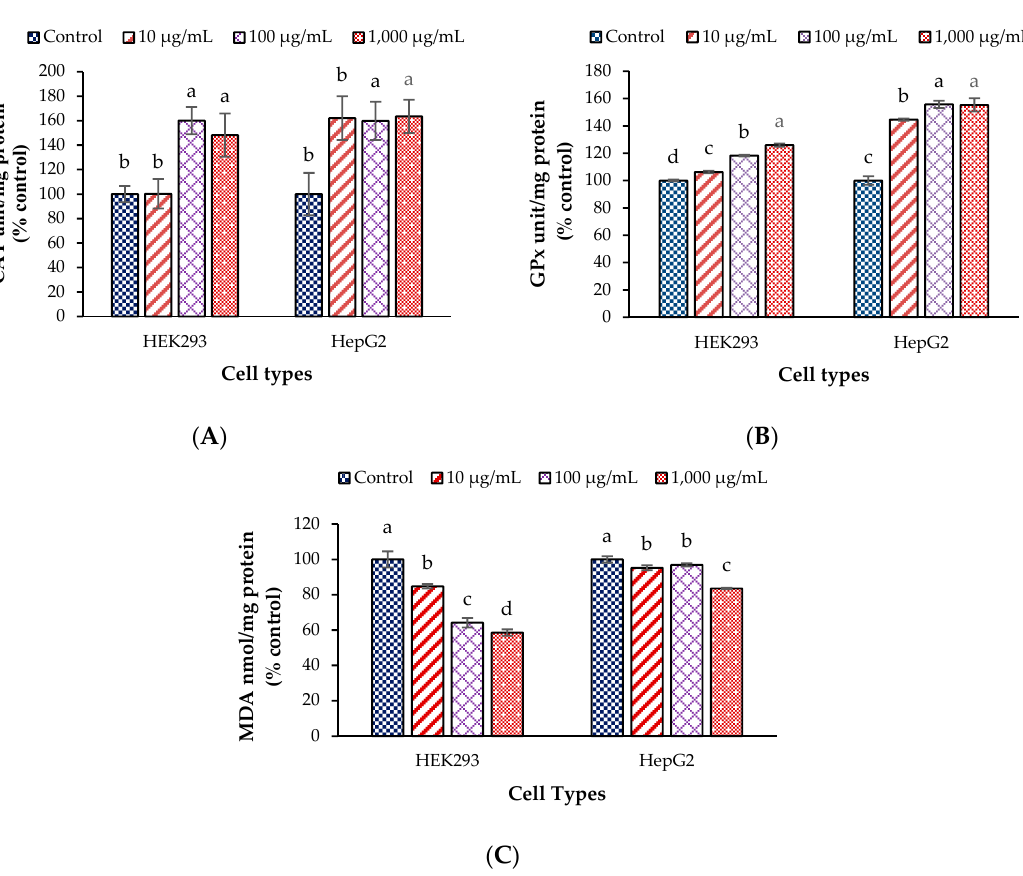
Figure 1. Antioxidant enzyme activities and malondialdehyde values of endogenous cellular extract (ECE) treated with T. lauriforlia extract in HEK293 and HepG2 cells; ( A ) catalase; ( B ) glutathione peroxidase and ( C ) malondialdehyde; a–d means with different letters are significantly different within a cell type ( p < 0.05); Values are presented as mean ± standard deviation.